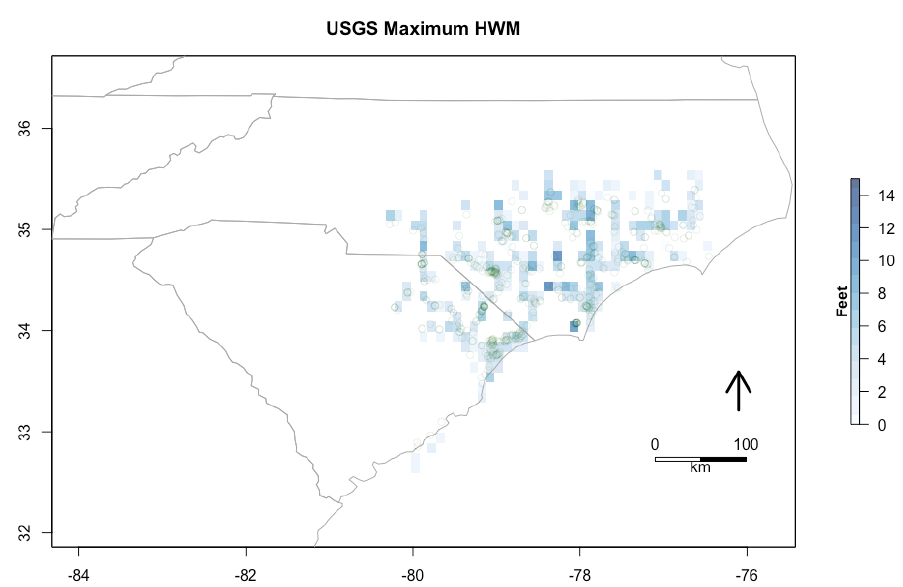
Figure 3. Raster visualization and location symbols of USGS high-water marks